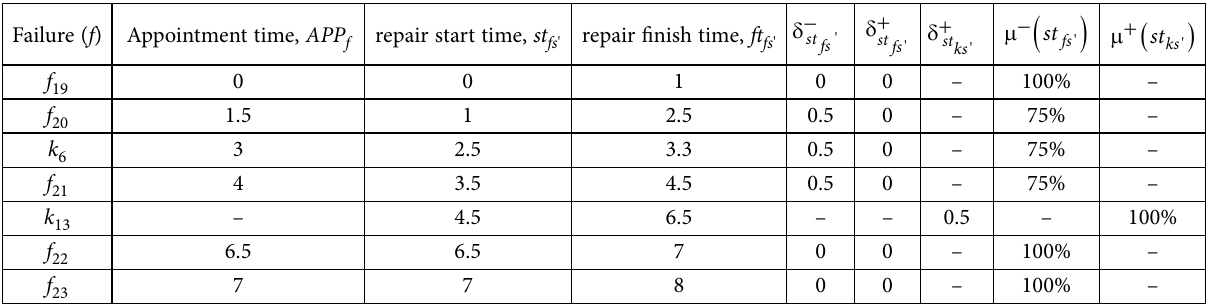
Table 11. The failure repairs’ new start times and satisfactions